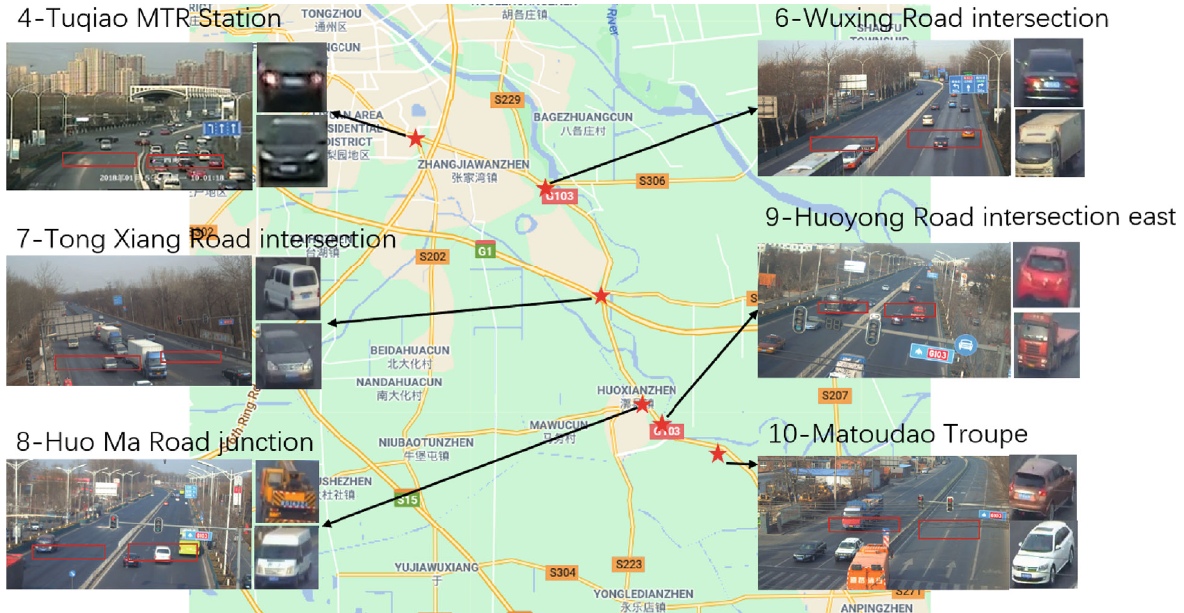
Figure 2: Points distribution and vehicle orientation in the direction of entering